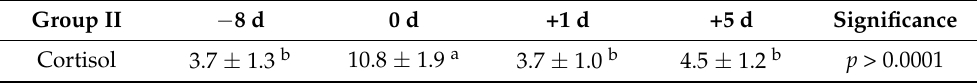
Figure 10. Representation of the mean values of serum cortisol levels of samples from animals in group II (16 to 30), found at the different moments of collection defined as − 8 d, 0 d, +1 d, and +5 d. Statistical difference according to the Tukey–Kramer test—Beltsville, 2003. a = significant statics difference.